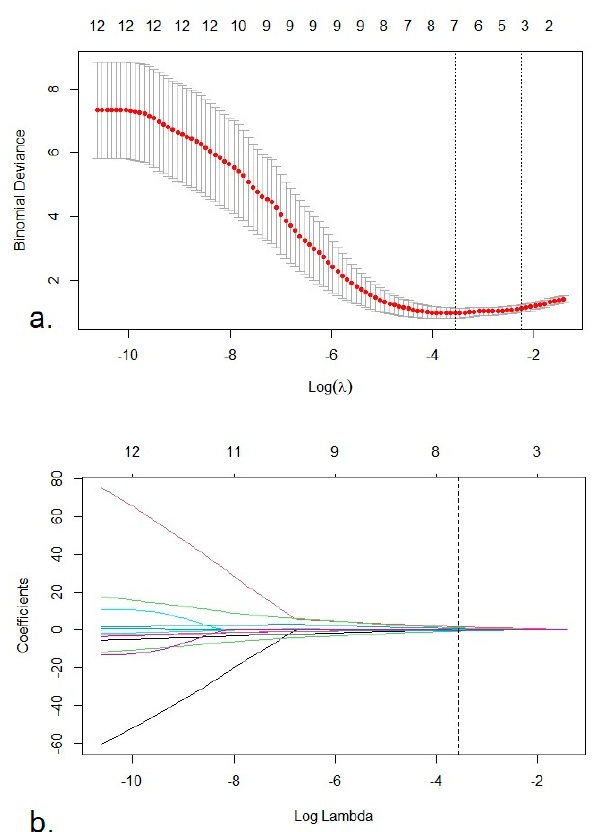
Figure 1. ( a ) Selection of the tuning parameter lambda ( λ ) using 10-fold cross validation. Binomial deviances from the least absolute shrinkage and selection operator (LASSO) regression cross-validation model were plotted as a function of log ( λ ). The dotted vertical lines were drawn at the optimal λ value based on the minimum criteria and 1 standard error of the minimum criteria. The optimal λ value of 0.028 and log ( λ ) = − 3.57 was selected. ( b ). LASSO coefficient profiles of the 12 radiomics features. The vertical dotted line was plotted at the optimal λ value, resulting in seven radiomics feature with non-zero coefficients. Table 2. List of selected radiomics features and their coe ffi cients for calculation of the radiomics